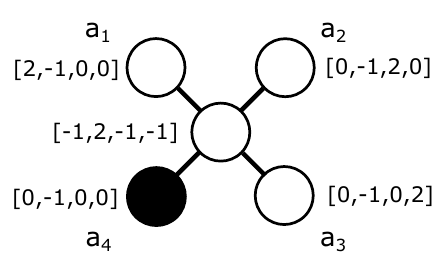
Figure 4. The affine D 4 Dynkin diagram with the affine node given in black. The four digits in a bracket indicate the Dynkin label for each node. a i next to a circle implies that this node is Higgsed when a i = 2